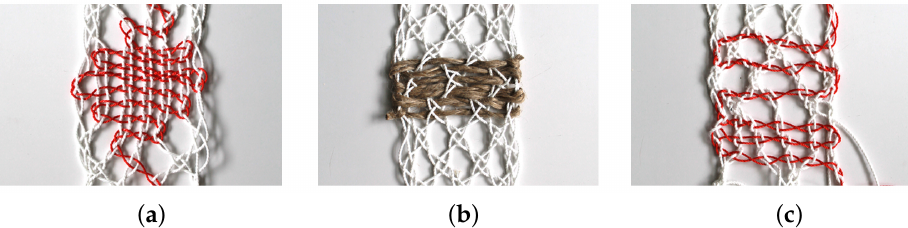
Figure 10. Experiments with traditional bobbin lace strategies as reinforcement ( a ) Cloth stitch. ( b ) Weave. ( c ) Skipped weave.